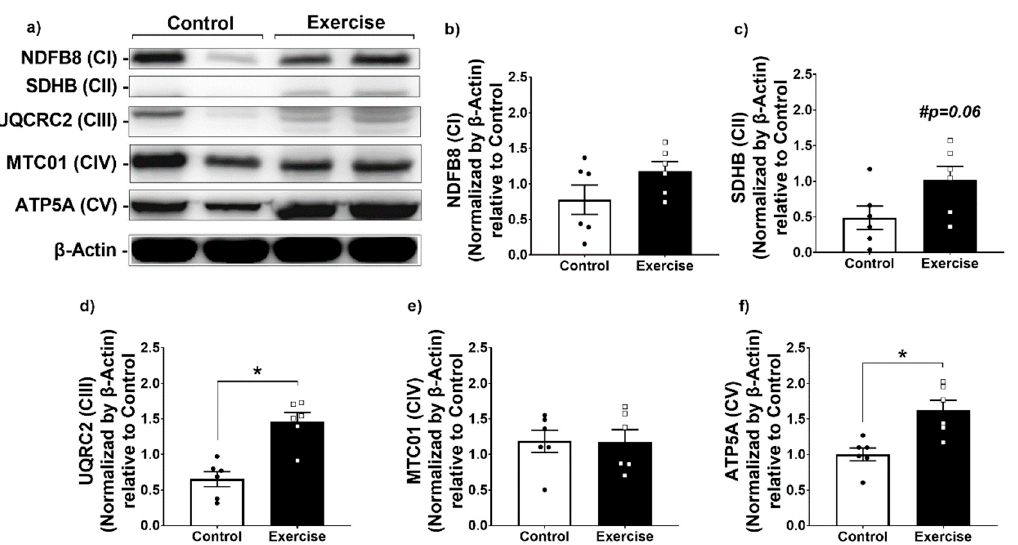
Figure 3. Aerobic exercise increased mitochondrial complexes expression in retroperitoneal WAT.